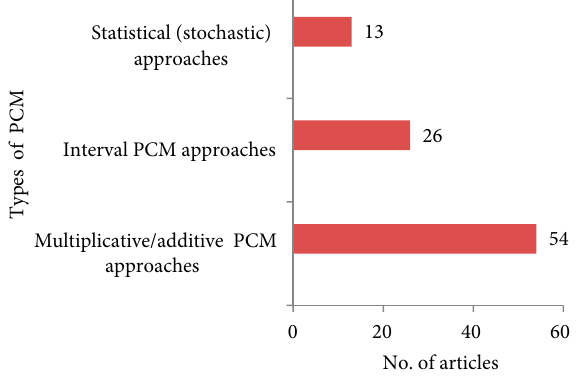
Fig. 1. The distribution of researches on three classes of PCMs